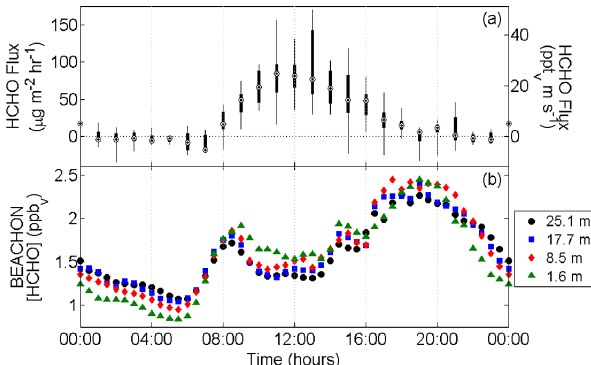
Fig. 4. (a) Hourly box-and-whisker plots of HCHO flux over en- tire measurement period. Black and white targets denote the hourly medians, thick black lines denote the interquartile range, and thin black lines denote the full range. (b) Diurnal medians of HCHO vertical concentration profiles from 12–22